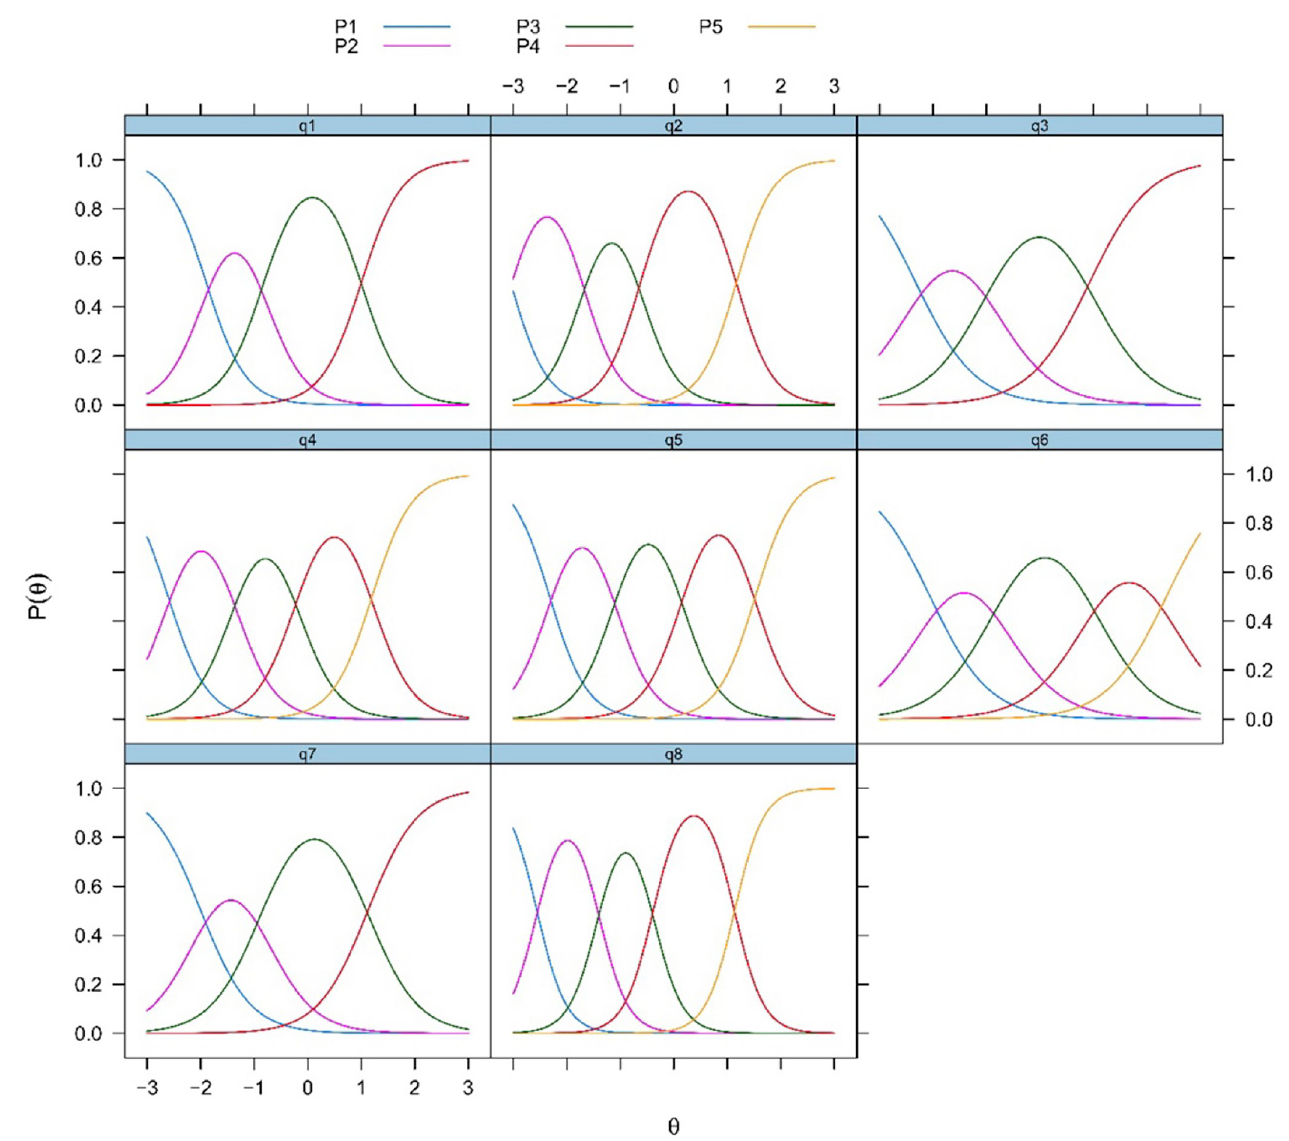
Fig 2. Category characteristic curves of the